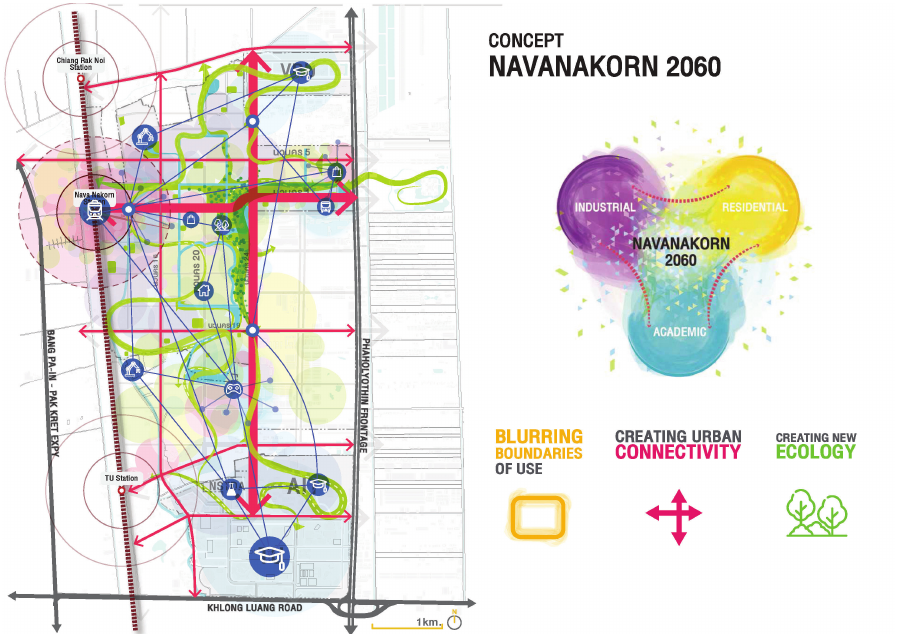
Figure 6. VRU/Nava Nakorn/Thammasat University corridor development vision, with the themes of blurring boundaries in land use, creating urban connectivity within the smart district, and creating a new ecology through enhanced green space planning and connectivity. The extension of the SRT Dark Red Line to Nava Nakorn is visioned to the west, with enhanced internal connectivity of shuttle- bus service represented by the red arrows. Graphics credits to Thanakit Singduang, Thanyamon Traimittaparp, Areerat Joemkor, Kotchakorn Chaiyatum, Apicha Promnao, Thannicha Charoenwan, Thanawit Likhitworasak, Phatharamon Panon, Nanthicha Jiwatjanarodom, AR416